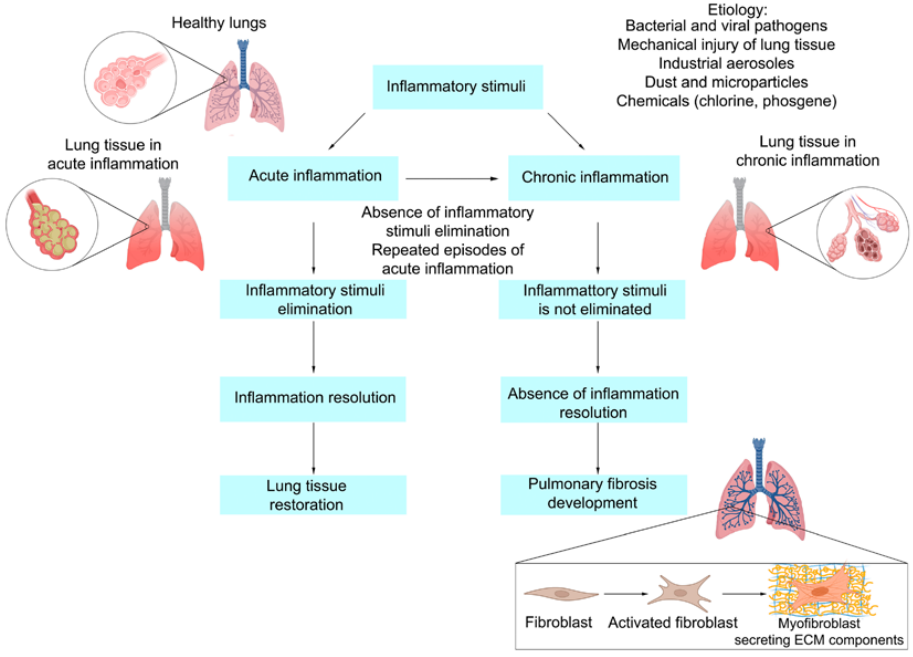
Figure 1. General scenarios of lung inflammation development: variants and outcomes.